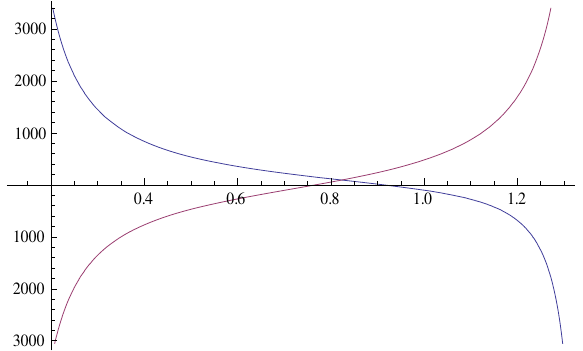
Fig. 1. Change of differences of pollution quotas with unit cost of